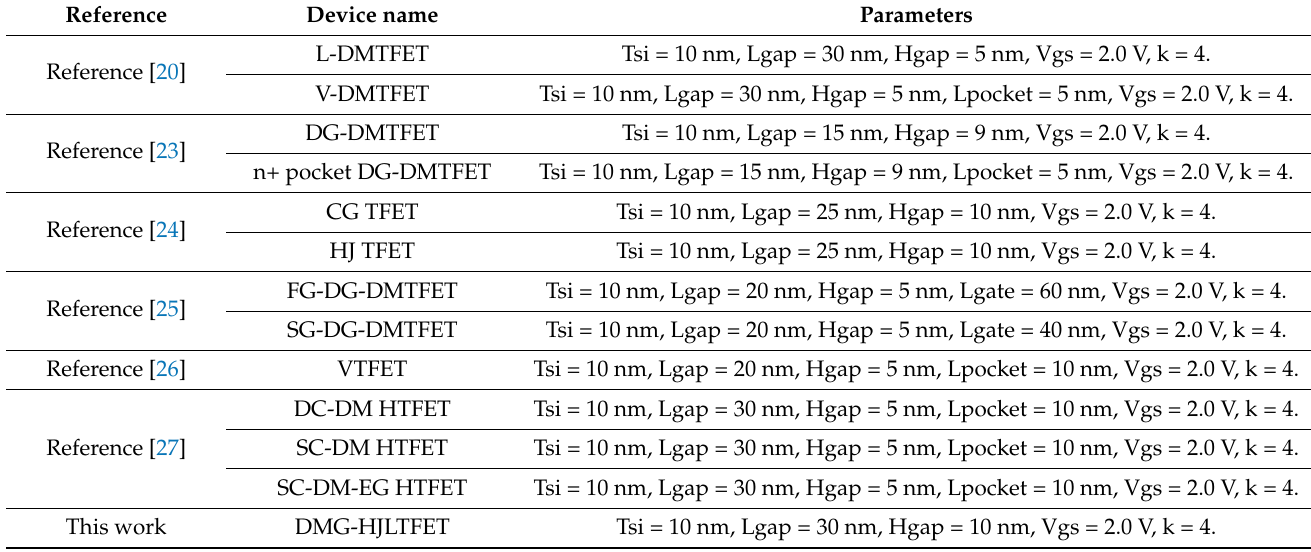
Table 5. Details of different TFET-based biosensors from Figure